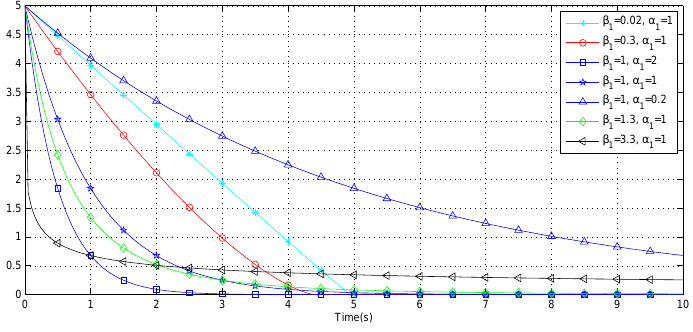
Figure 2. The Parameter analysis of terminal sliding mode